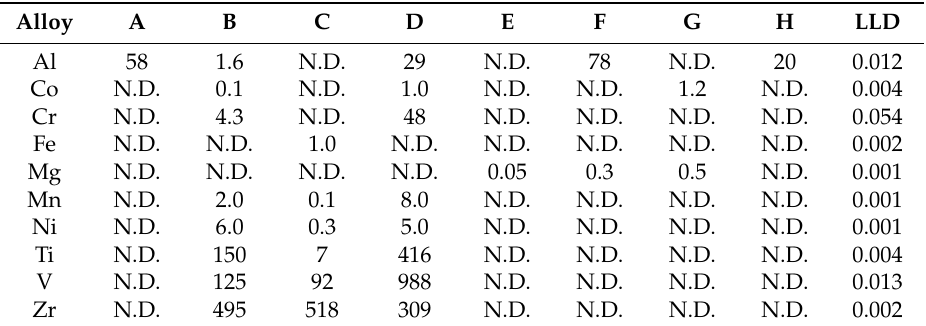
Table 4. ICP results (in unit of ppm) from the solutions after etching experiment. N.D. and LLD denote non-detectable (below LLD) and lowest limit of detection,